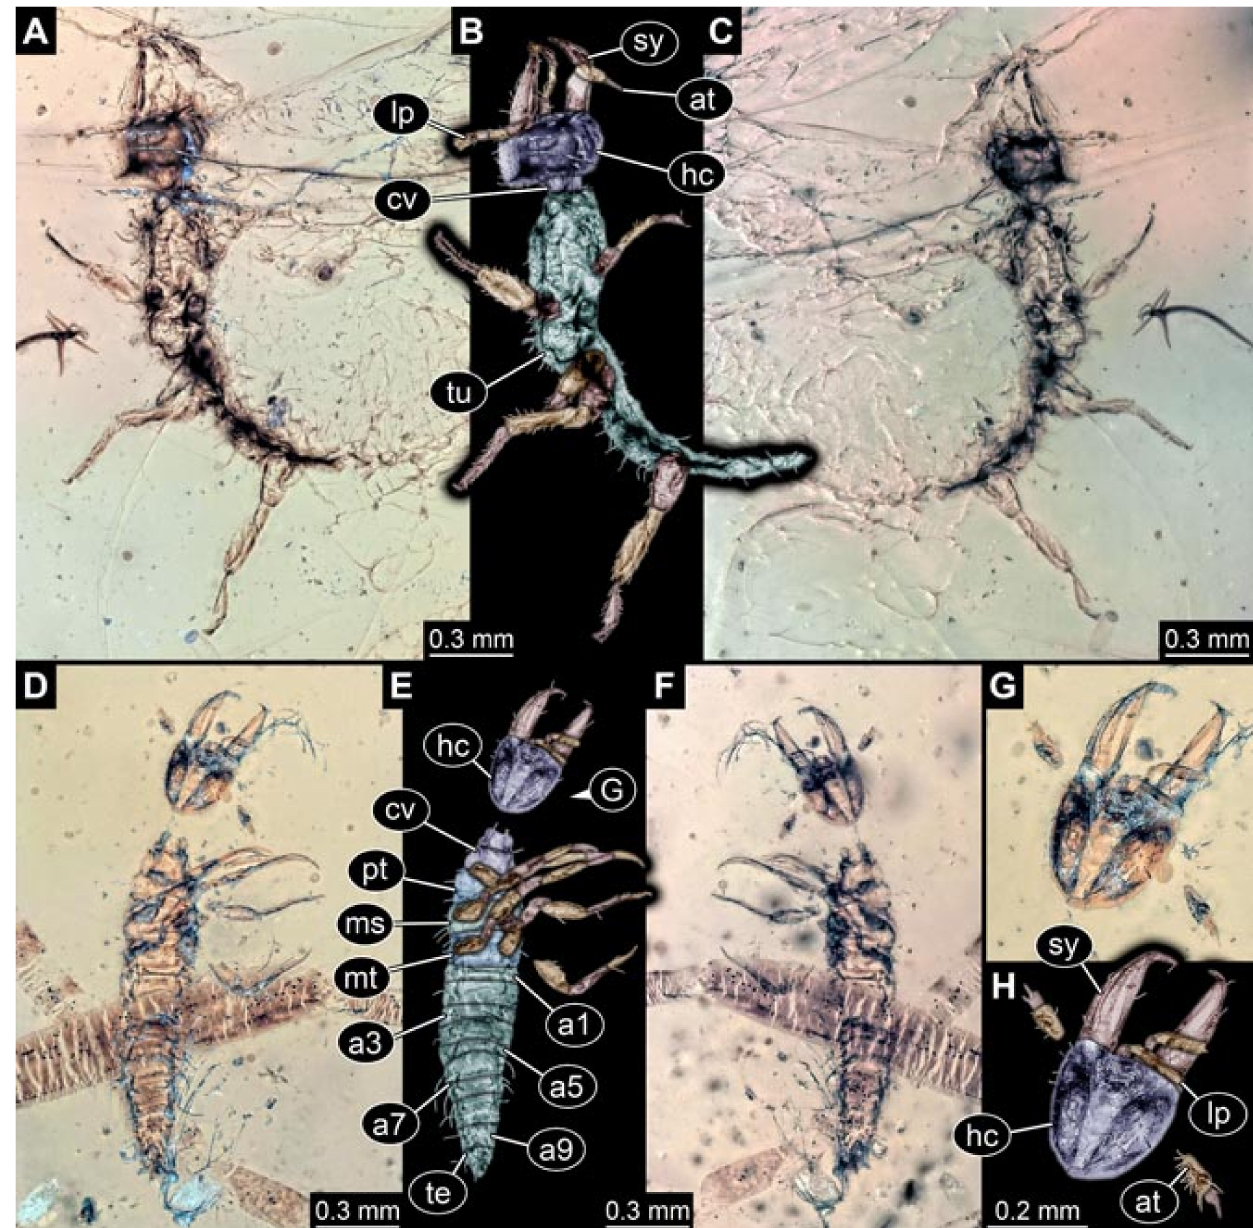
Figure 22. Specimens in Myanmar amber. ( A – C ) Specimen 5852 (PED 0791-3). ( A ) Ventral view. ( B ) Ventral view, colour-marked. ( C ) Dorsal view. ( D – H ) Specimen 5853 (PED 0791-4). ( D ) Ventral view. ( E ) Ventral view, colour-marked. ( F ) Dorsal view. ( G ) Close-up of head in ventral view. (H) Close-up of head in ventral view, colour-marked. Abbrevi- ations: a1–a9 = abdomen segment 1–9; at = antenna; cv = cervix; hc = head capsule; lp = labial palp; ms = mesothorax; mt = metathorax; pt = prothorax; sy = stylet; te = trunk end; tu =